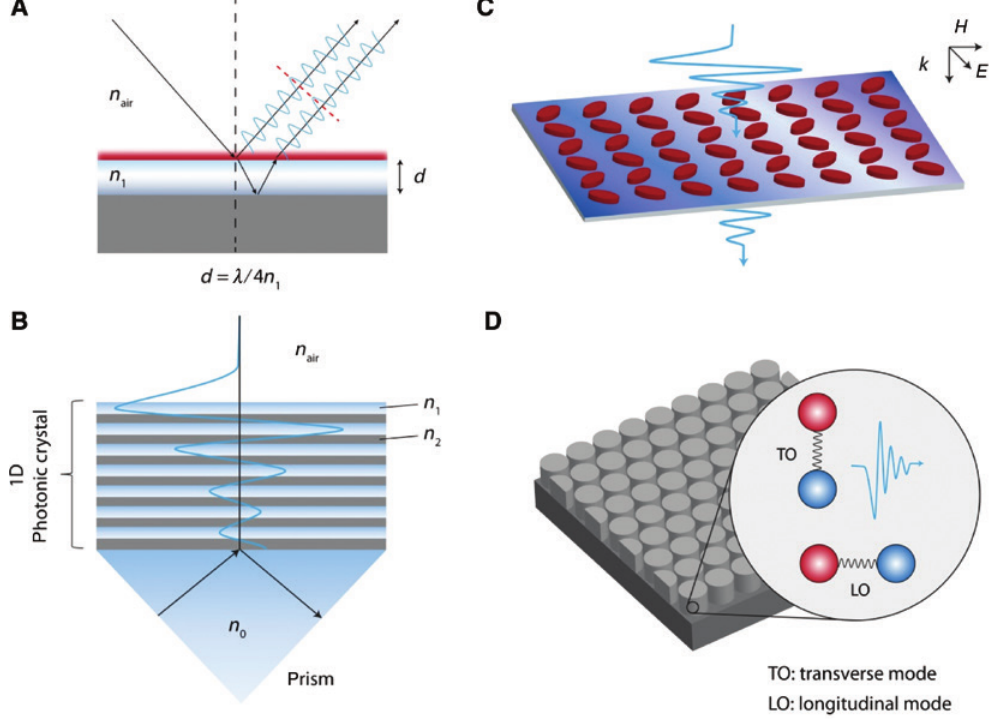
Figure 1: Schematic display of nonplasmonic enhancement mechanisms discussed in this review. (A) Interference enhancement due to a layer of specific thickness deposited on a reflective surface. (B) BSWs in 1D photonic crystals launched by internal reflection. (C) BICs as representative for arrays of nonabsorbing or weakly absorbing dielectric nanostructures/ metasurfaces. (D) Structures for